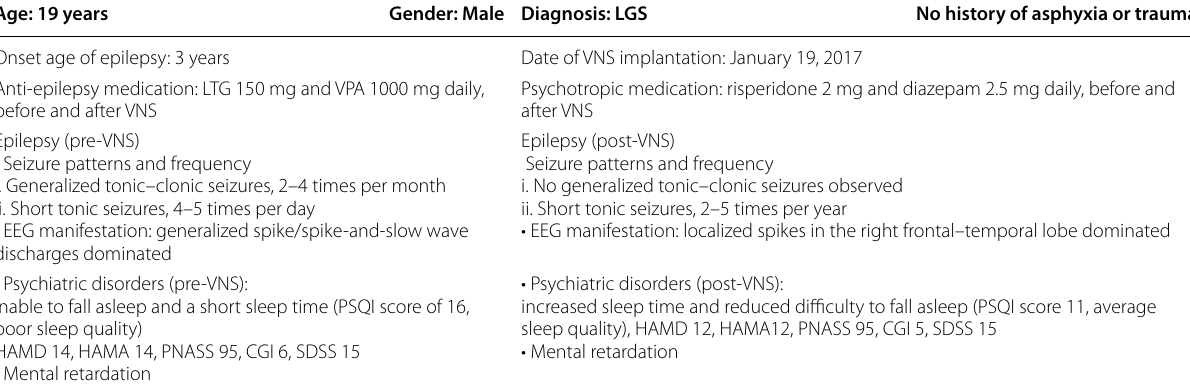
Table 1 The demographic information and clinical characteristics of the patient Age: 19 years Gender: Male Diagnosis: LGS No history of asphyxia or trauma Onset age of epilepsy: 3 years Date of VNS implantation: January 19,